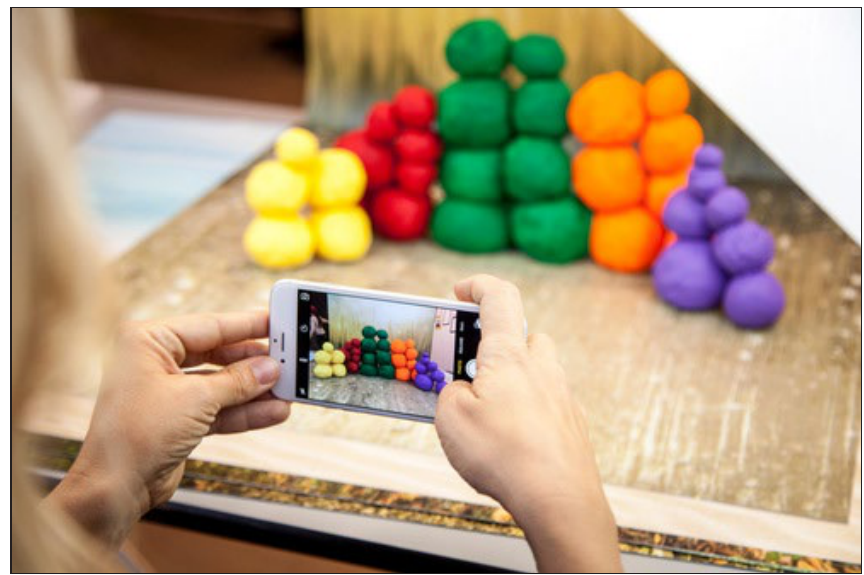
Figure 1: Jill Miller. Family Portraits. 2016 ongoing. Photo courtesy of Michael